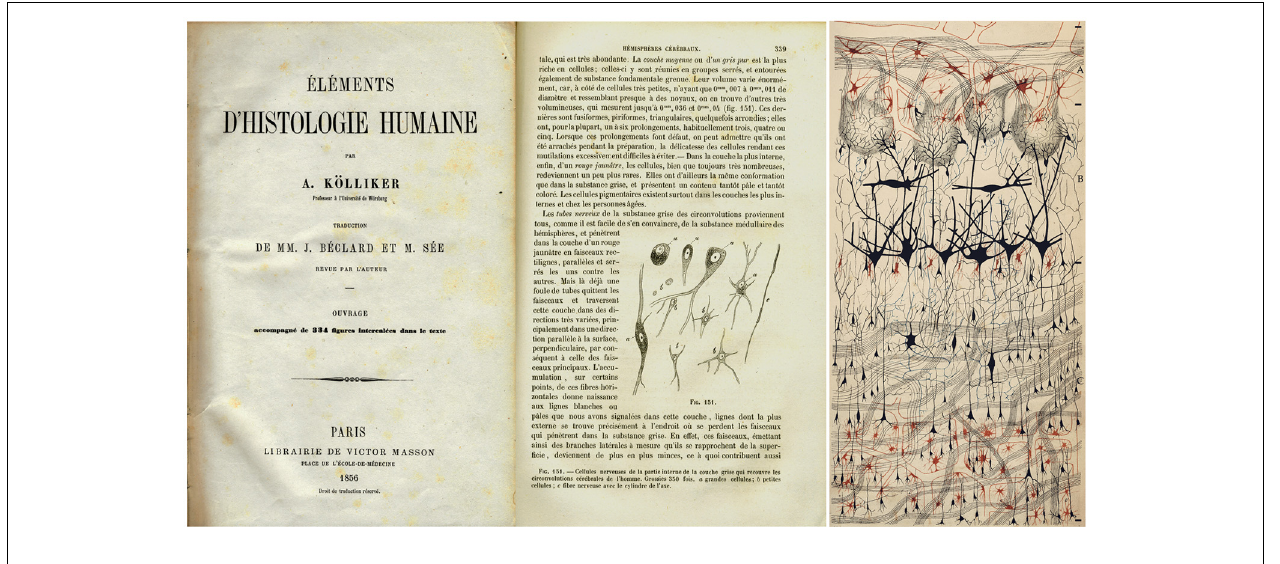
FIGURE 1 | Illustrations showing the evolution of the visualization of the structure of the nervous system. Left: drawing by Kölliker to show different cell types in the cerebral cortex (Published in 1856 in the French edition of Kölliker (1852), classic book Handbuch der